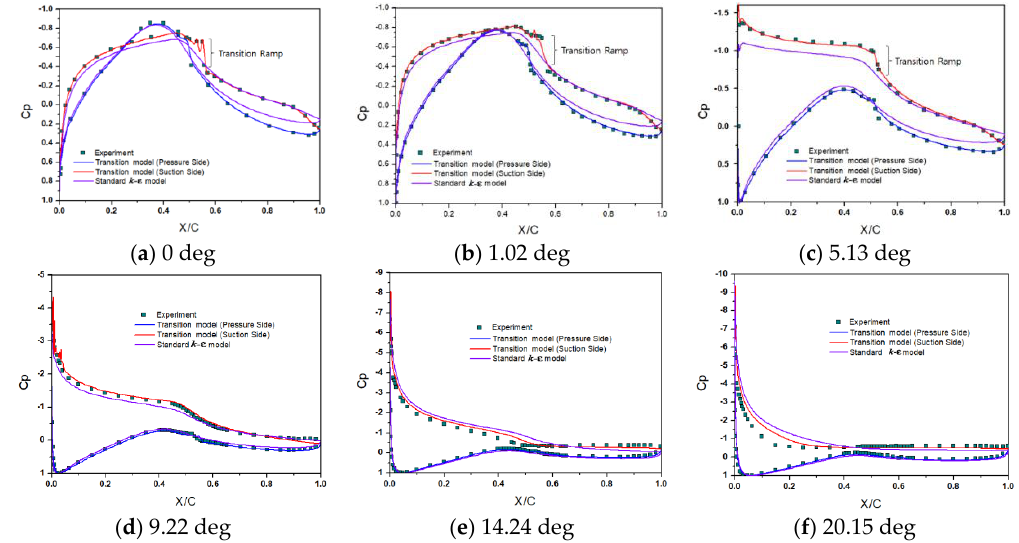
Figure 6. Comparison between the experiment and the simulation results of the pressure coefficient (C p ) with different turbulence models at selected angles of attack (AoAs) of 0° ( a ), 1.02° ( b ), 5.13° ( c ), 9.22° ( d ), 14.24° ( e ), and 20.15° ( f ) for the S809 airfoil (Re = 2 × 10 6 ).